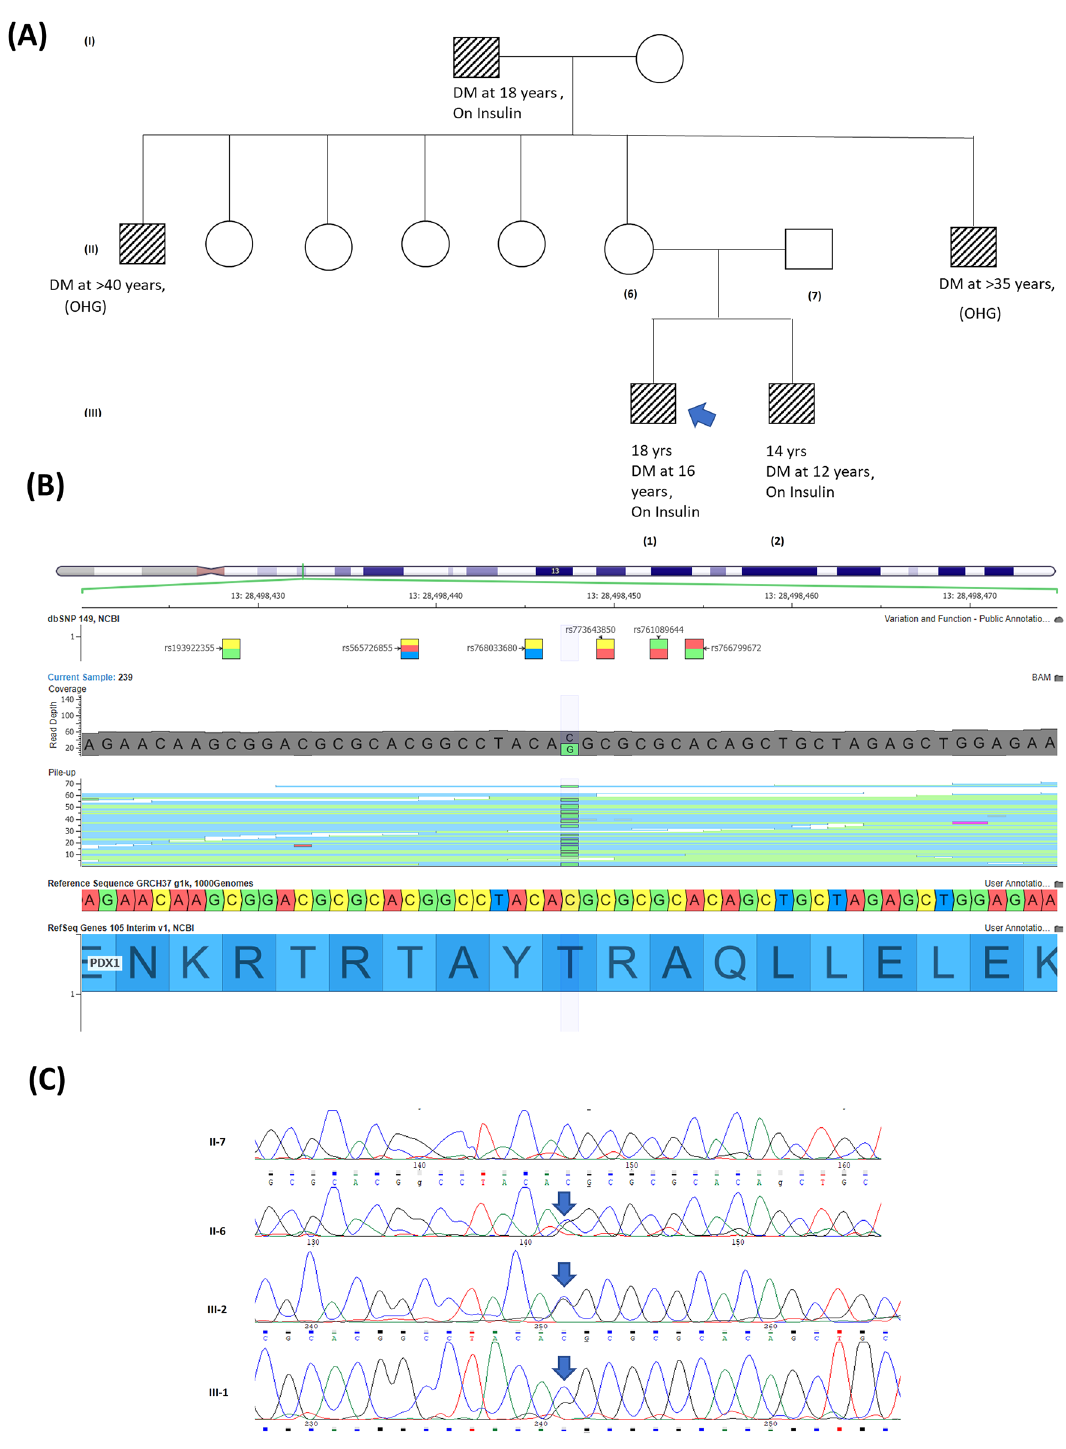
Figure 1. ( A ) Represents pedigree of a family positive for Maturity Onset Diabetes of the Young (MODY4). The square symbol represents male, and the circle represents female. The filled in symbols indicate affected individuals and the blue arrow indicates the index case. Next generation sequencing revealed a novel heterozygous missense variant in Pancreatic and duodenal homeobox 1 (PDX1) c.461C > G resulting in p.Thr154Arg. ( B ) Exome sequencing summary layout depicting part of the PDX1 gene location on chromosome 13 at the top and the exons coverage in green and blue. The location of the variants in exon 2 is represented by a vertical green bar and the reference sequence and the altered codon is highlighted. (C) Chromatogram represents Sanger sequencing results confirming the segregation of heterozygous variants in the mother, the index case and his